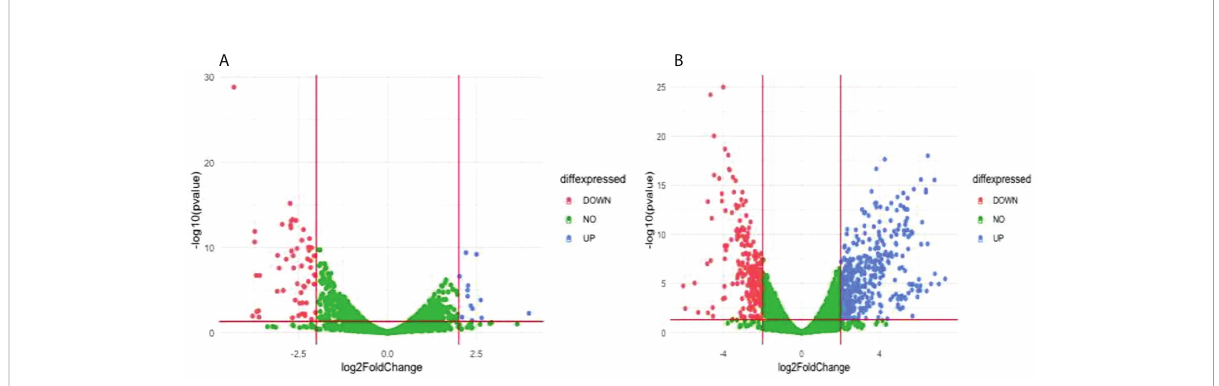
FIGURE 7 Differentially expressed genes (DEG) between compared conditions for the DD2 parasite line. Scatter plots indicate the genes differentially expressed (log2 fold expression change > 2 and with a p-value < 0.05). Red vertical lines indicate absolute log2 fold change >2 and red horizontal line indicates p-value < 0.05. (A) Volcano plot for DD2_DMSO treated versus DD2_DHA treated; 13 genes were upregulated, and 55 genes were downregulated (B) Volcano plot for DD2_untreated compared with DD2_DHA; 403 genes were upregulated and 247 downregulated genes.